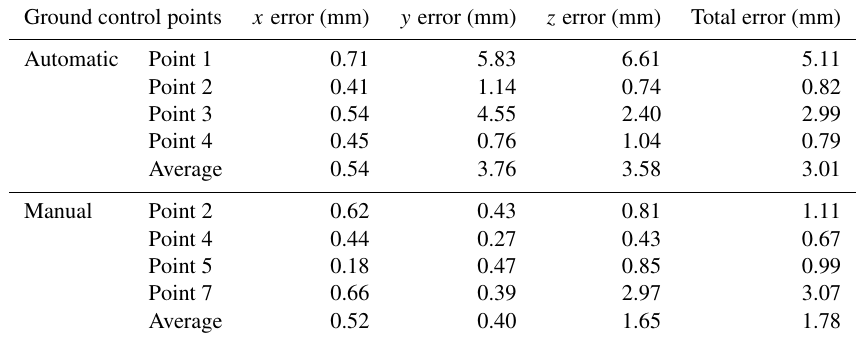
Table 2. Control point RMSE for manual and automatic photogrammetry Ground control points